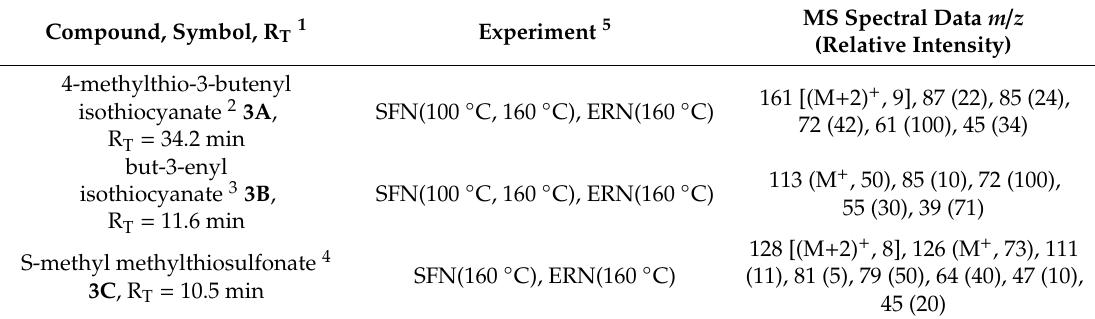
Table 1. Names, retention times and mass spectral data for three products of thermal decomposition of neat SFN / ERN at temperatures 100 ◦ C and 160 ◦ C.